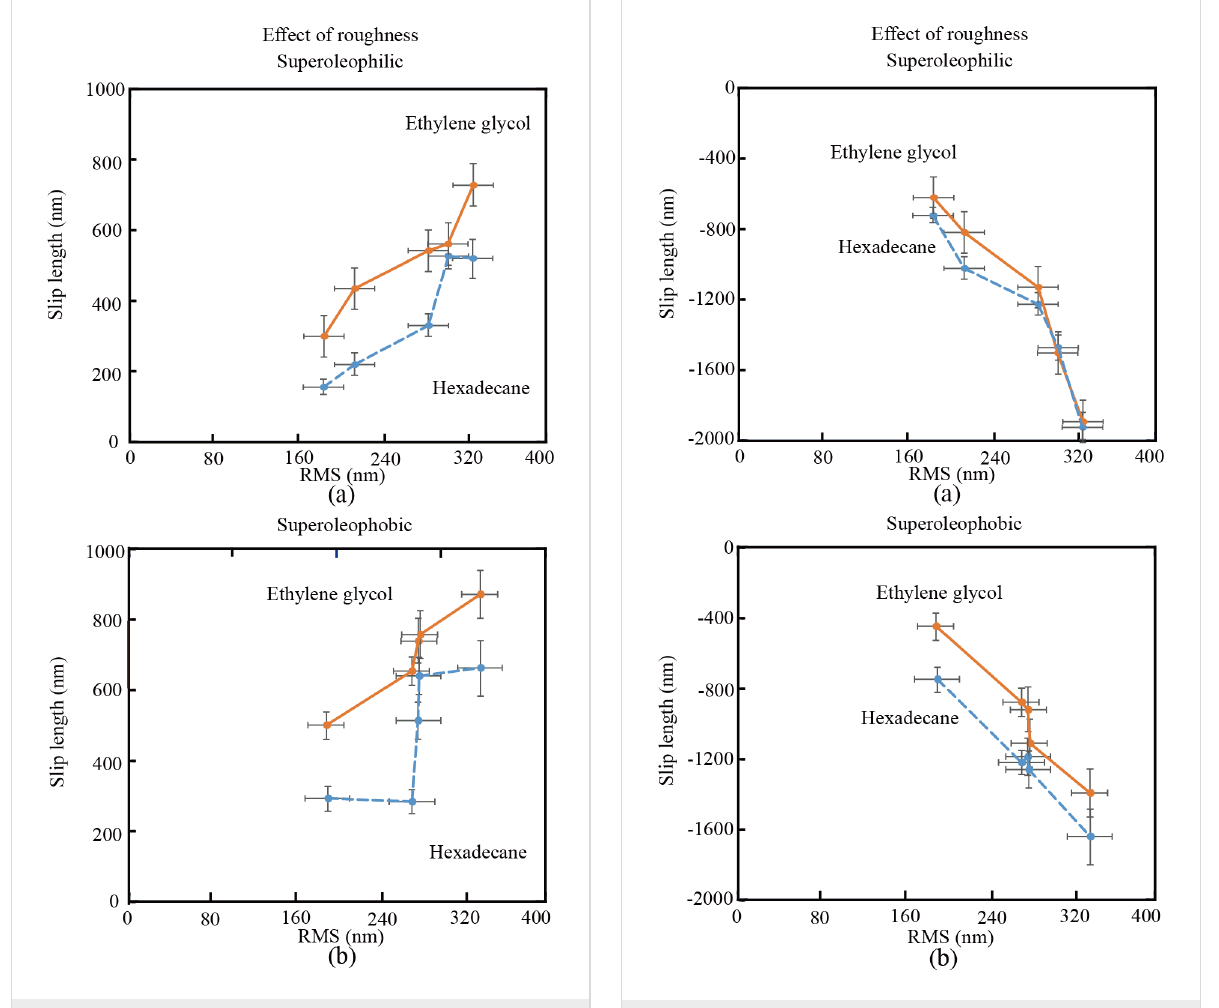
Figure 8: Effective slip length on superoleophilic and superoleophobic surfaces with varying values of RMS roughness immersed in hexade- cane and ethylene